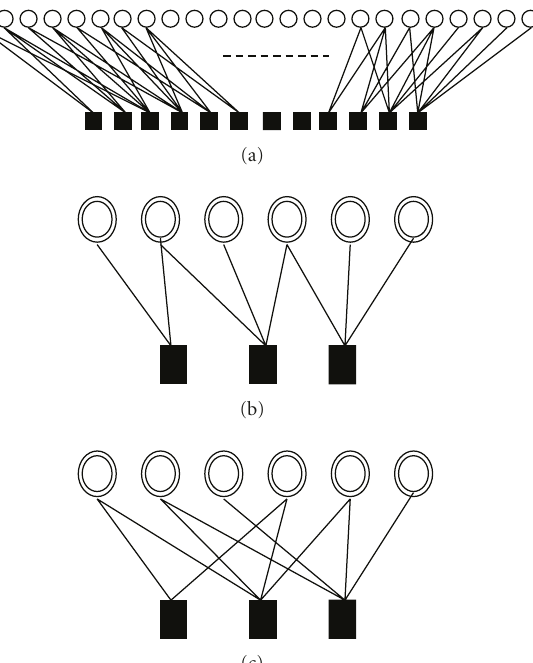
Figure 2: Comparison of di ff erent Tanner graph representations of the recursive systematic convolutional code with bit clustering of order p = 4 versus those of the binary image defined by H